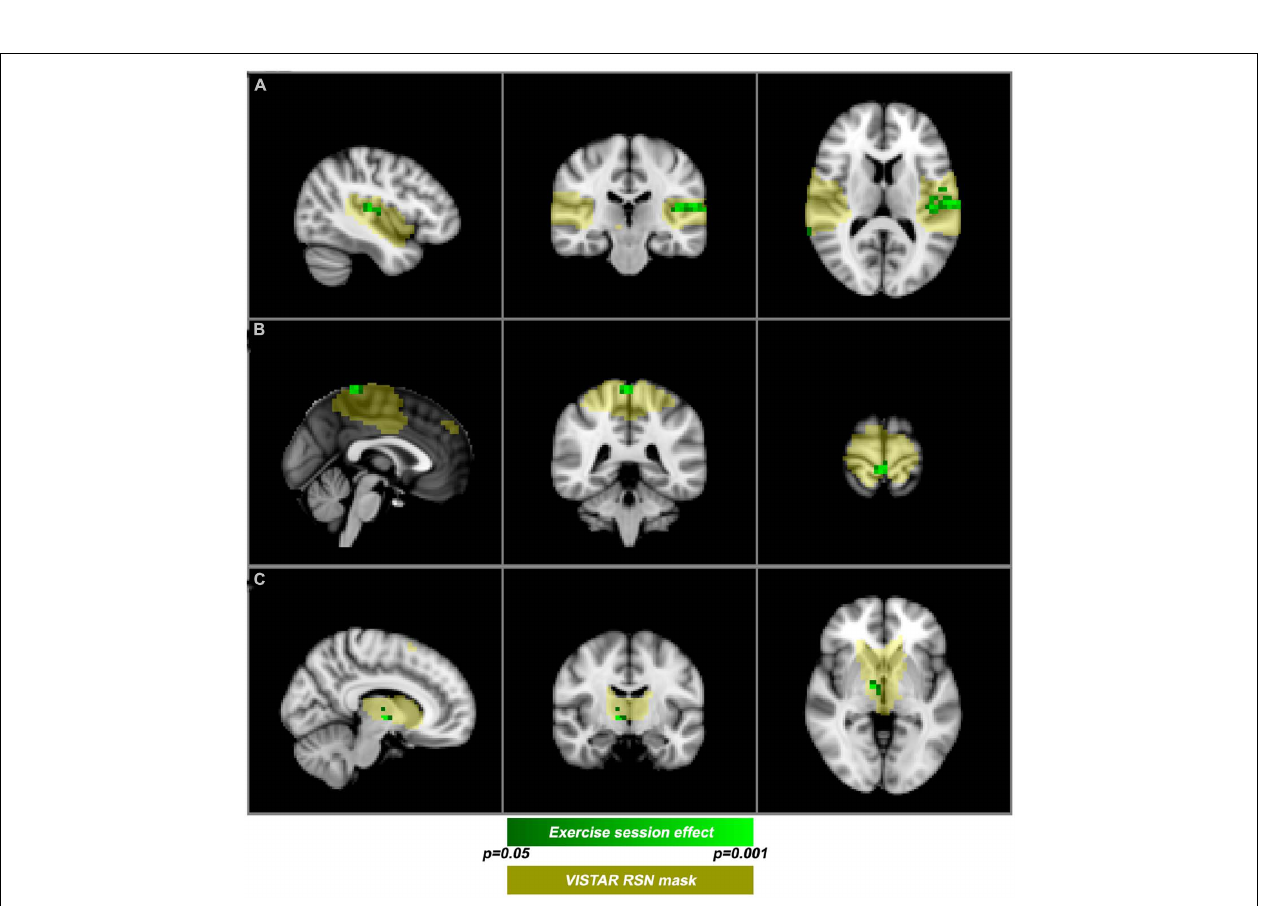
FIGURE 3 | Post-exercise changes in resting-state functional magnetic resonance imaging functional magnetic resonance imaging (rs-fMRI). VISTAR RSNs (yellow) overlaid with cluster enhanced-regions of increased co-activation (green): (A) auditory RSN [MNI( − 42, − 24,12)], (B) sensorimotor RSN [MNI (0, − 40,72)], (C) Thalamic-Caudate RSN [MNI (10, − 10, −